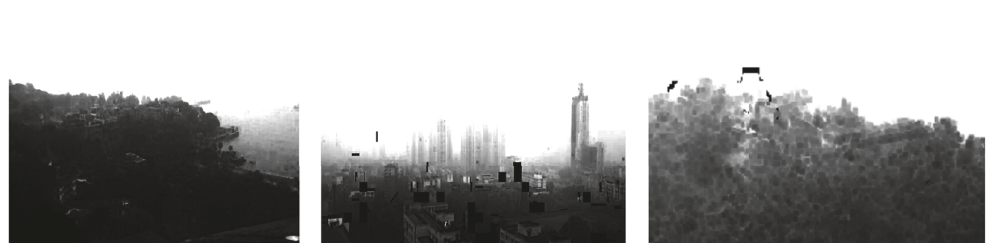
Figure 8: Image form of three color channels’ maximum difference